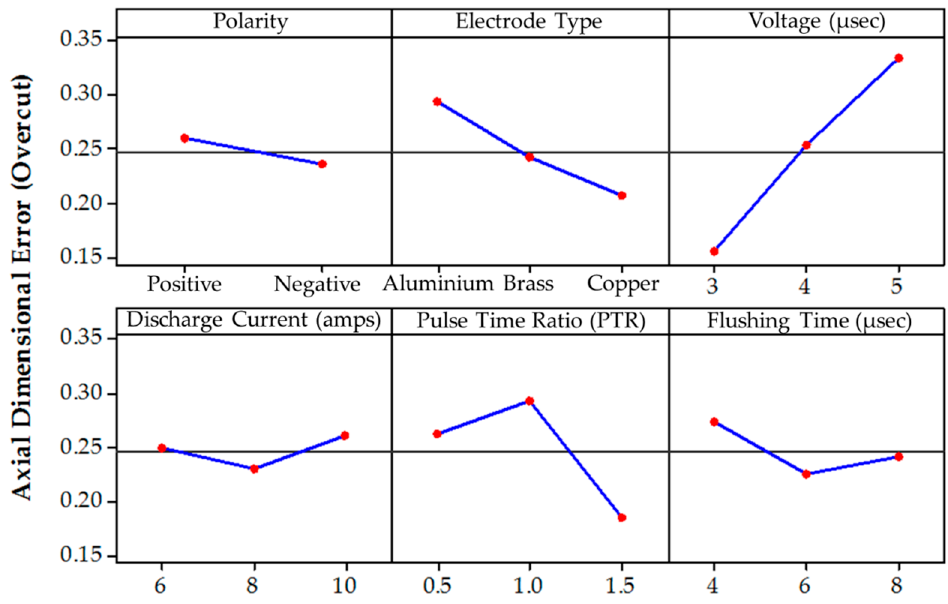
Figure 13. Average experimental results obtained for the axial dimensional error by varying each control parameter for the EDM process including graphene-based dielectric fluid.